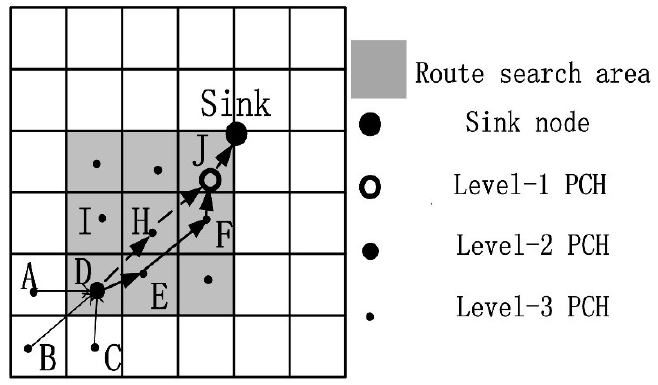
Figure 5. Routing strategies of QTGrid.